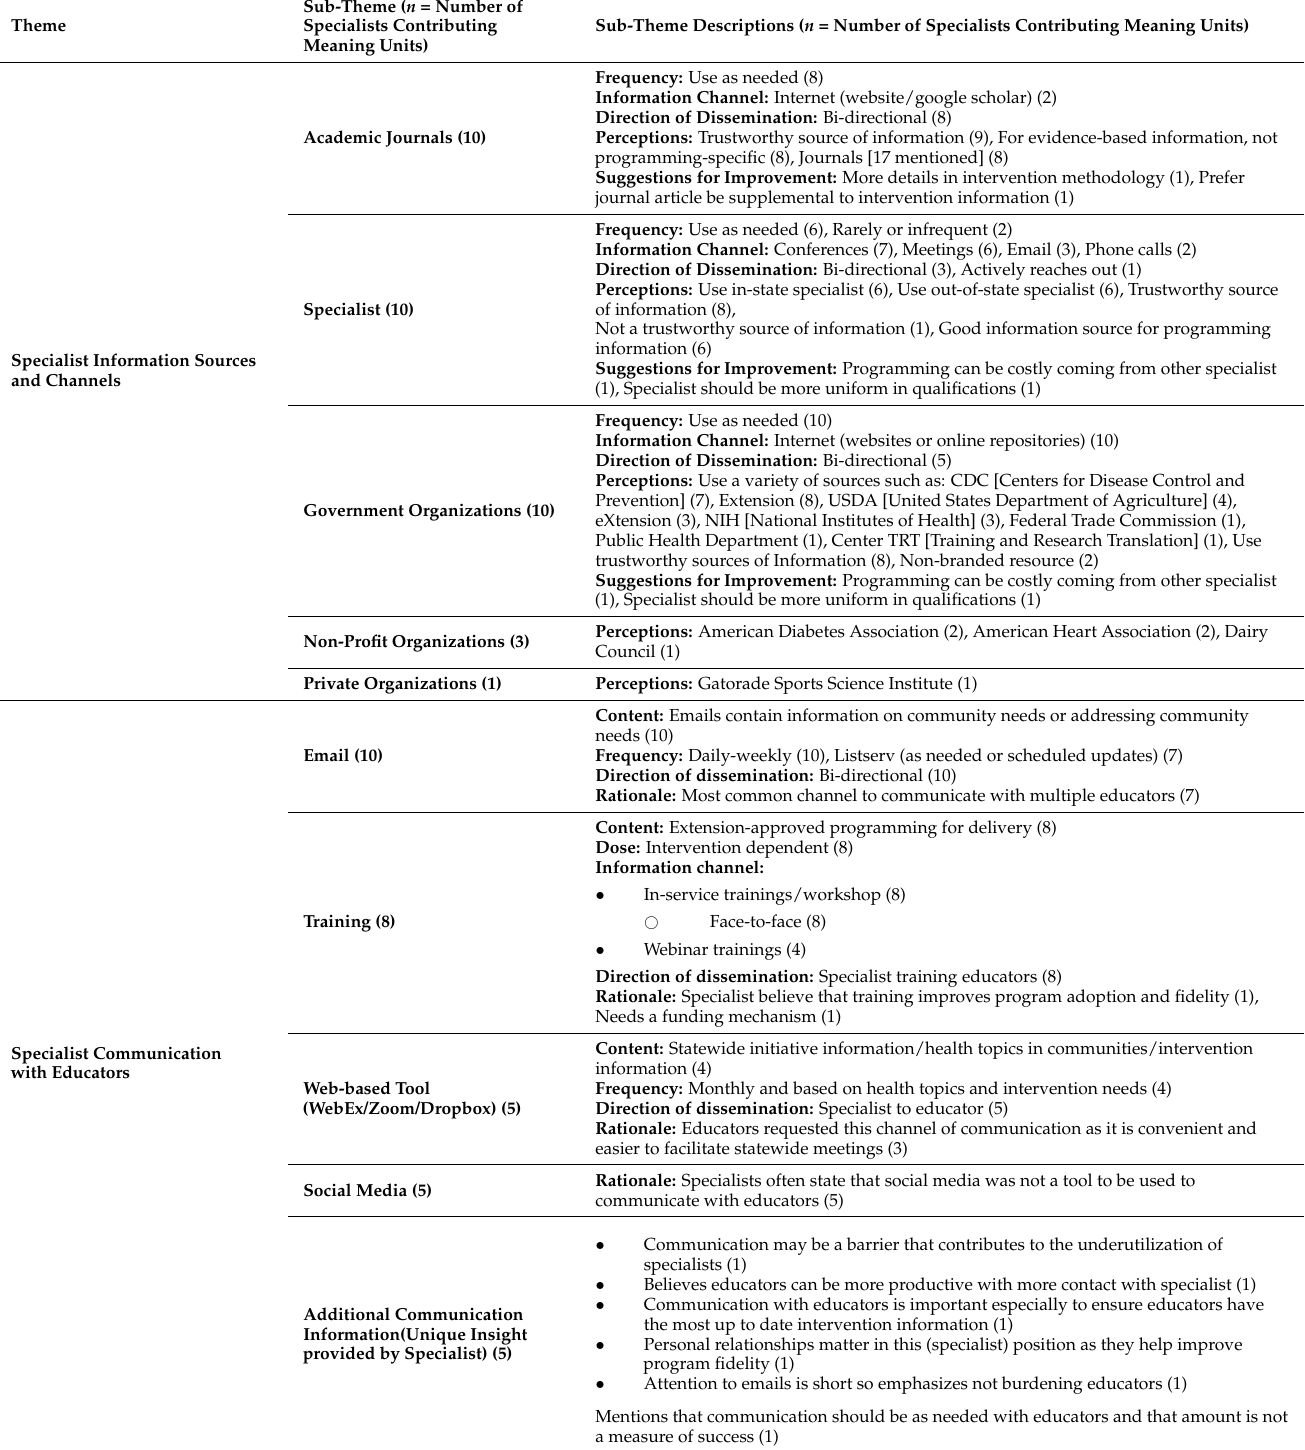
Table 2. Specialist Interview Qualitative